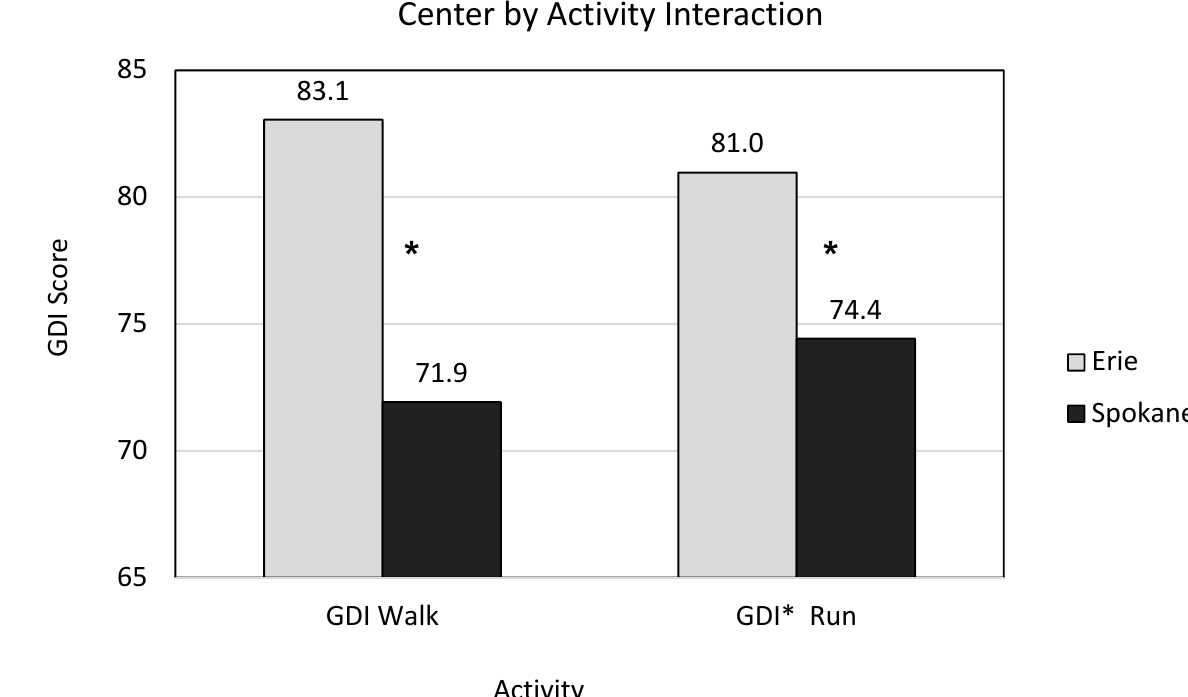
Figure 1. Comparison of Gait Deviation Index (GDI) for walking vs running for children with diplegic Cerebral Palsy at each Center. GDI Walk and GDI* Run were not significantly different from each other at either center. Both GDI Walk and GDI* Run were significantly higher at Erie compared to Spokane indicated by * using Student-Newman-Keuls post-hoc test.